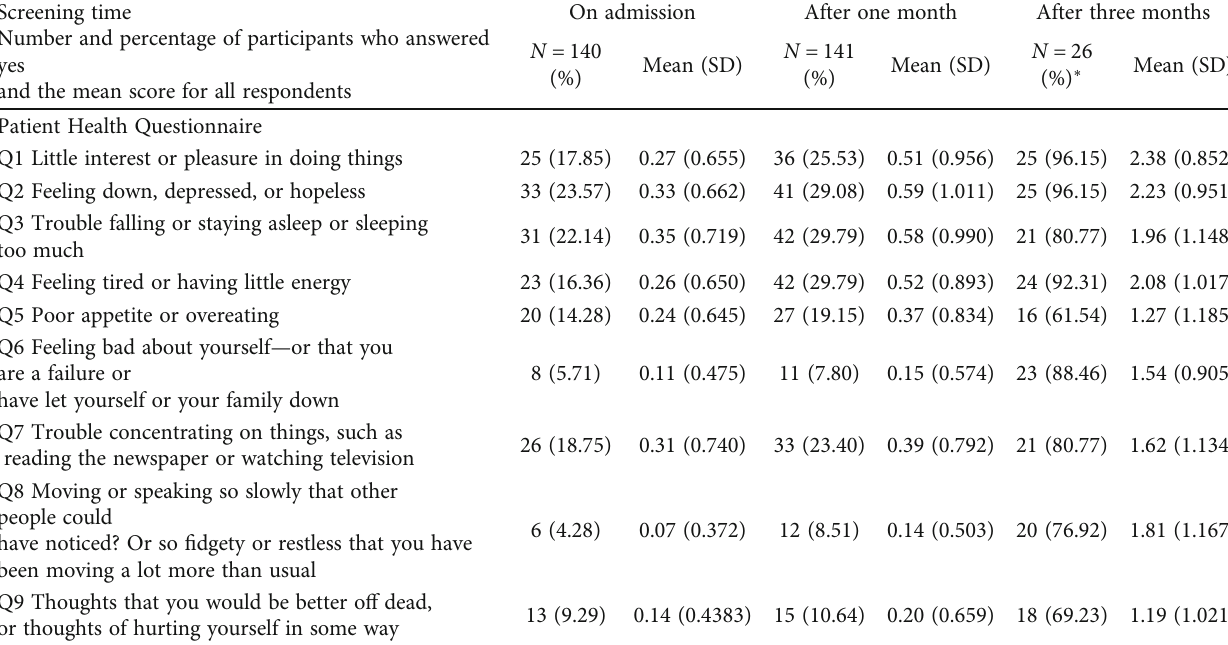
Table 5: The most a ff ected domain at di ff erent screening periods.